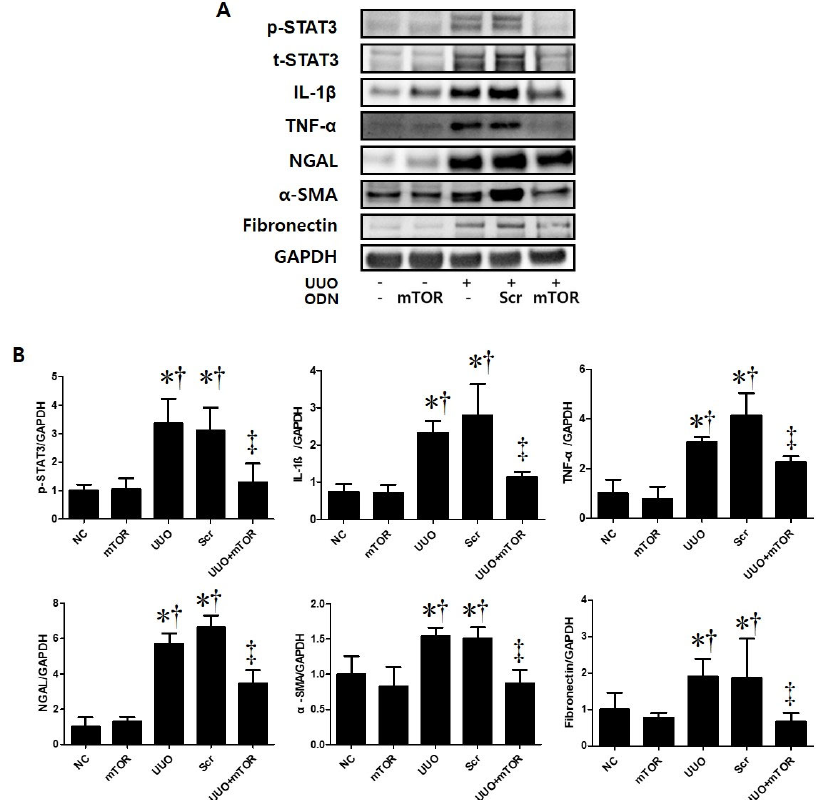
Figure 3. The mTOR ODN significantly attenuated UUO-induced inflammation, tubular injury, and fibrosis. ( A ) The results of Western blot analysis showed that mTOR ODN attenuated the expression of the phosphorylated signal transducer and activator of transcription 3 (p-STAT3), IL-1 β , TNF- α , NGAL, α -smooth muscle actin ( α -SMA), and fibronectin in UUO mouse model of kidney tissue. ( B ) The expression levels of p-STAT3, IL-1 β , TNF- α , NGAL, α -SMA, and fibronectin were quantified. Representative images from each group. The results are expressed as the mean ± SE of three independent determinations. * p < 0.05 vs. NC group. † p < 0.05 vs. mTOR group. ‡ p < 0.05 vs. UUO or Scr group. UUO, unilateral ureteral obstruction; ODNs, oligonucleotides; mTOR, mammalian target of rapamycin; NC, normal control; mTOR, injected with mTOR ODNs; UUO, UUO surgery; UUO + Scr, underwent UUO surgery and injected with scrambled ODNs; UUO + mTOR, underwent UUO surgery and injected with mTOR ODNs.